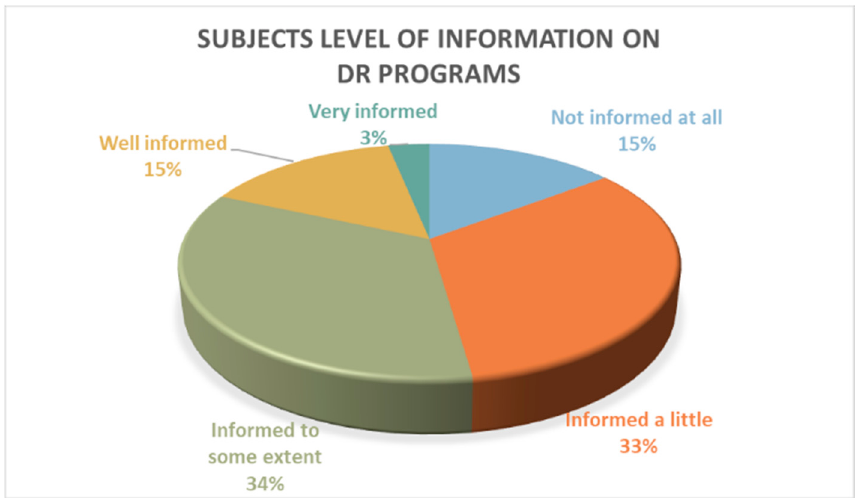
Figure 5. Consumers’ levels of information on Demand Response.